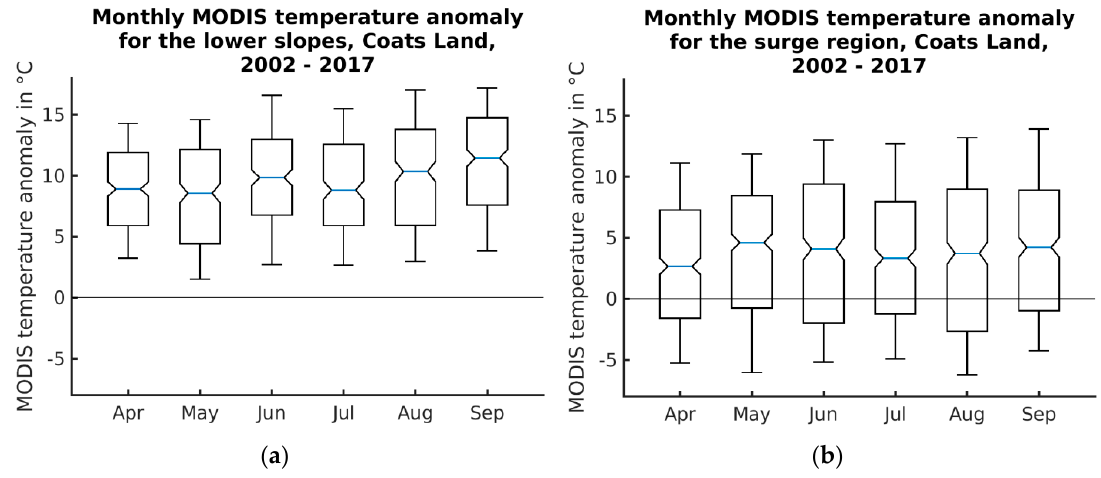
Figure 11. Box-whisker plot for the surface temperature anomaly for different months for winter (April–September) 2002 to 2017 for the eastern Weddell Sea for the slope ( a ) and surge areas ( b ). The median, the 25 and 75% percentiles are plotted as the box, the 10 and 90% percentiles are plotted as error bars.